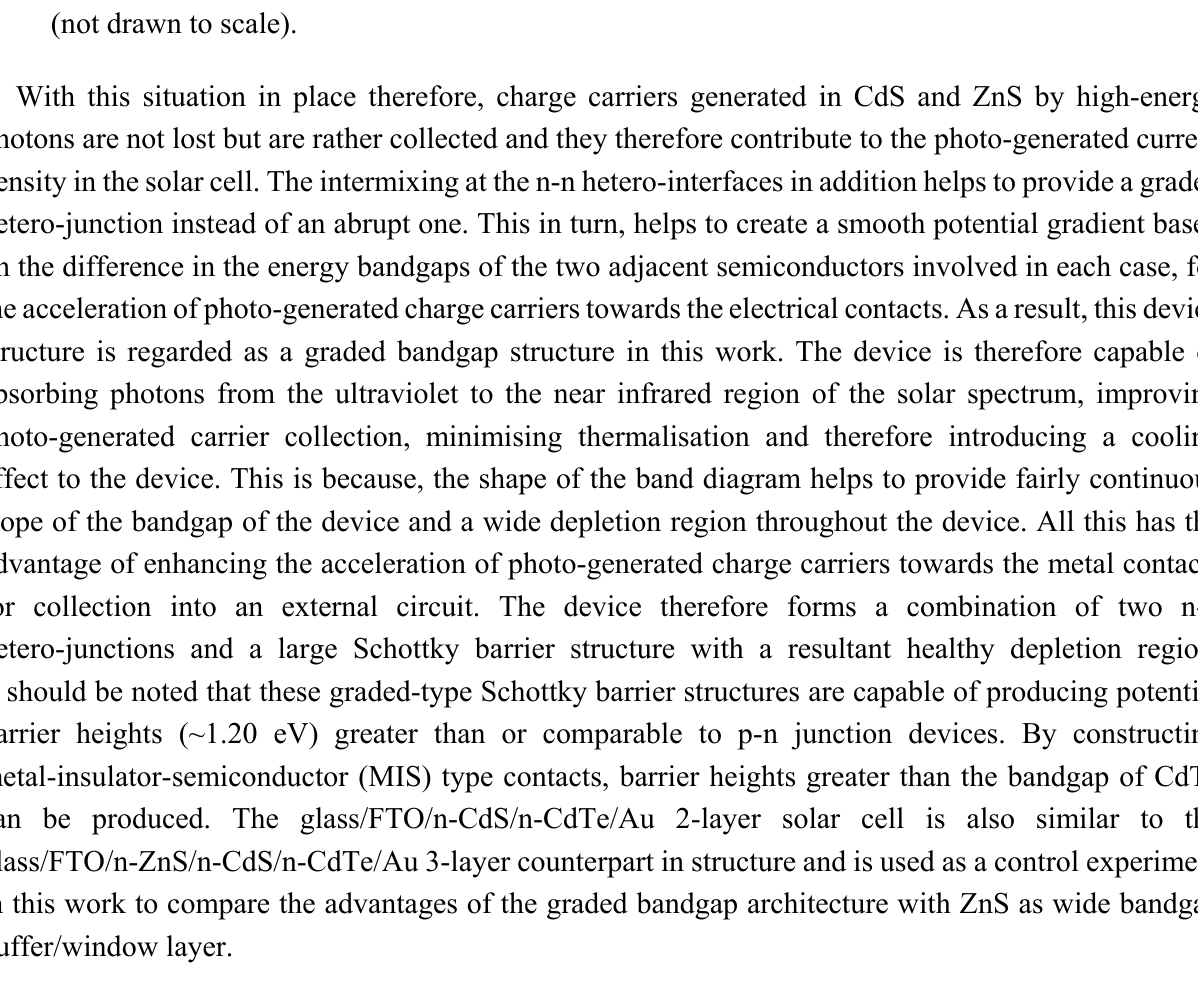
Figure 3. ( a ) Schematic of the glass/FTO/n-ZnS/n-CdS/n-CdTe/Au graded bandgap device and ( b ) Energy band diagram of the glass/FTO/n-ZnS/n-CdS/n-CdTe/Au graded bandgap solar cell structure showing impurity PV effect through defect levels in the bandgap of CdTe (not drawn to